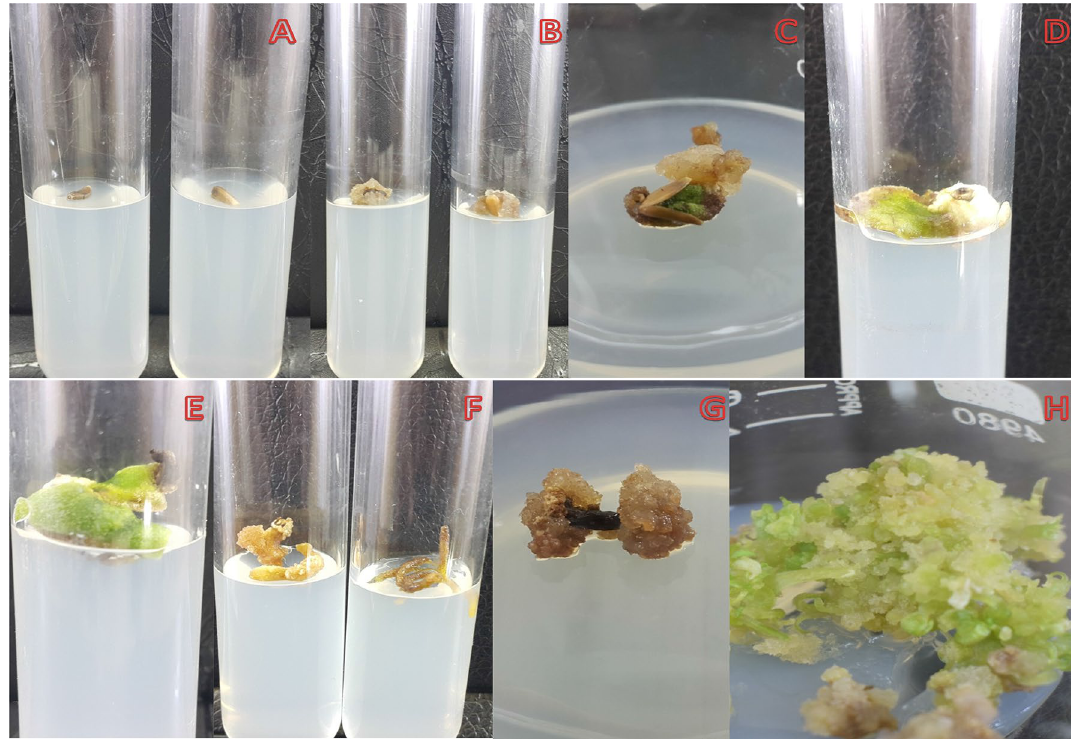
Figure 1. In-vitro callus induction of S. costus using seeds ( A , B , C ), leaf ( D , E ), roots ( F ) and nodes ( G ) as an